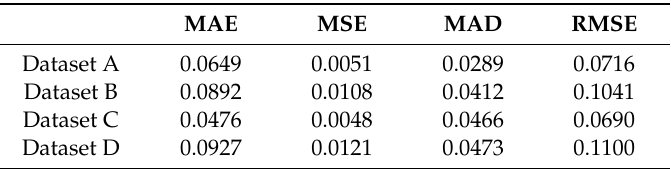
Table 3. GAN-SDAE system evaluation indexes. Table 4. GAN ‐ SDAE system evaluation indexes. Table 4. GAN ‐ SDAE system evaluation indexes.